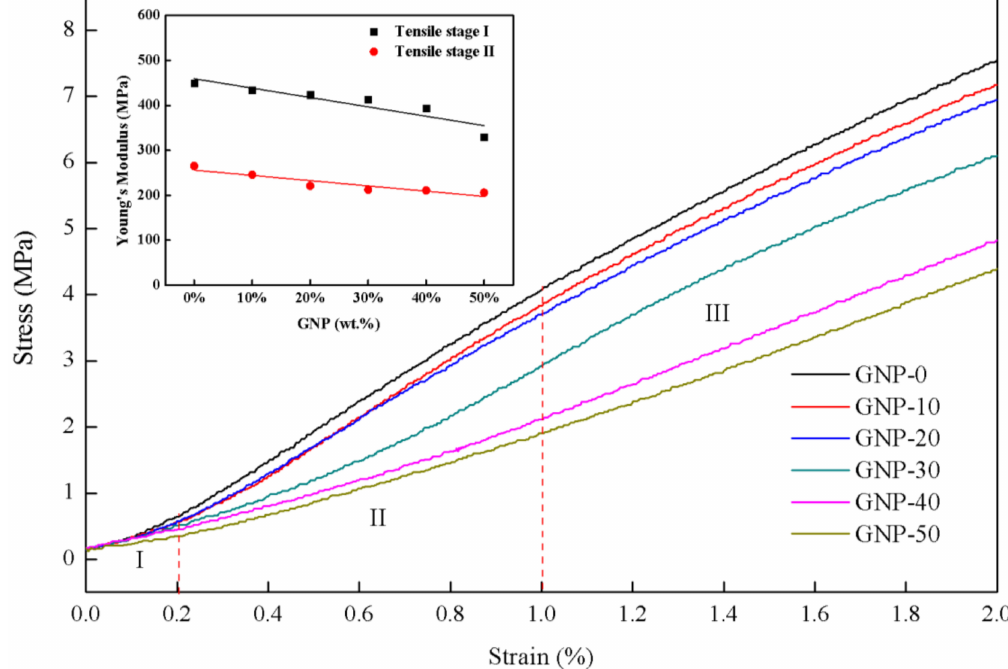
Figure 4. Enlarged stress –strain curve of MWCNT/GNP hybrid